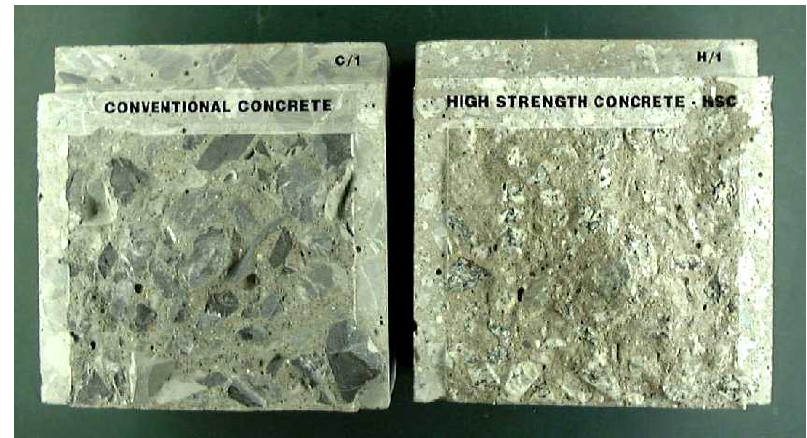
Figure 6. Conventional concrete (left) and high strength concrete (right) fractured